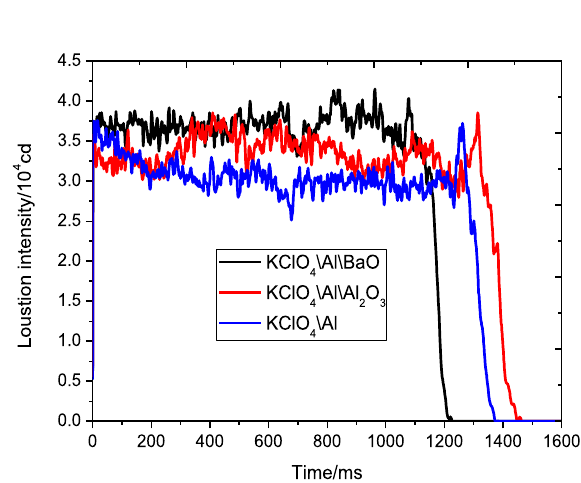
Figure 5. Light radiation intensity-time curve of KClO 4 /Al with different metal